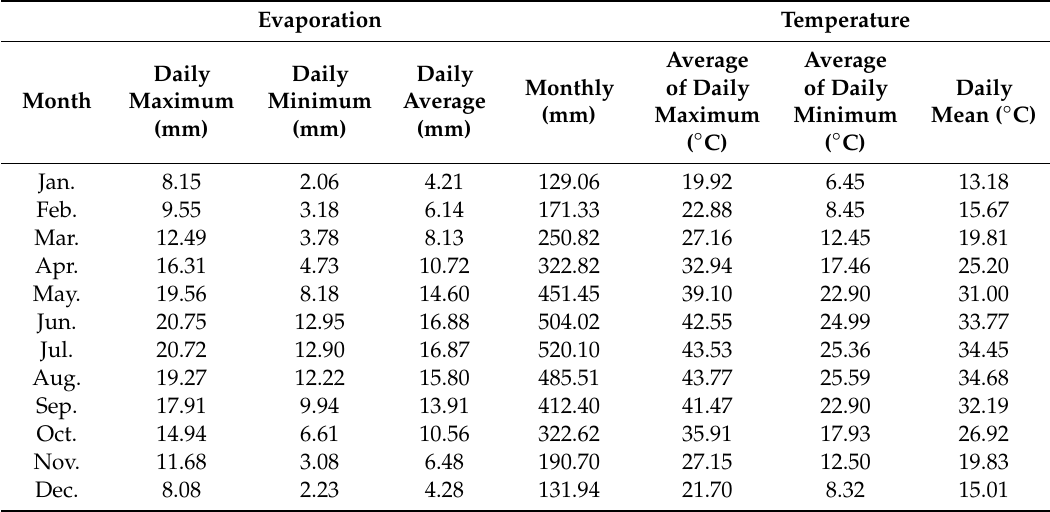
Table 2. Daily / monthly evaporation and average daily temperature (average for the period 1976–2016). Evaporation